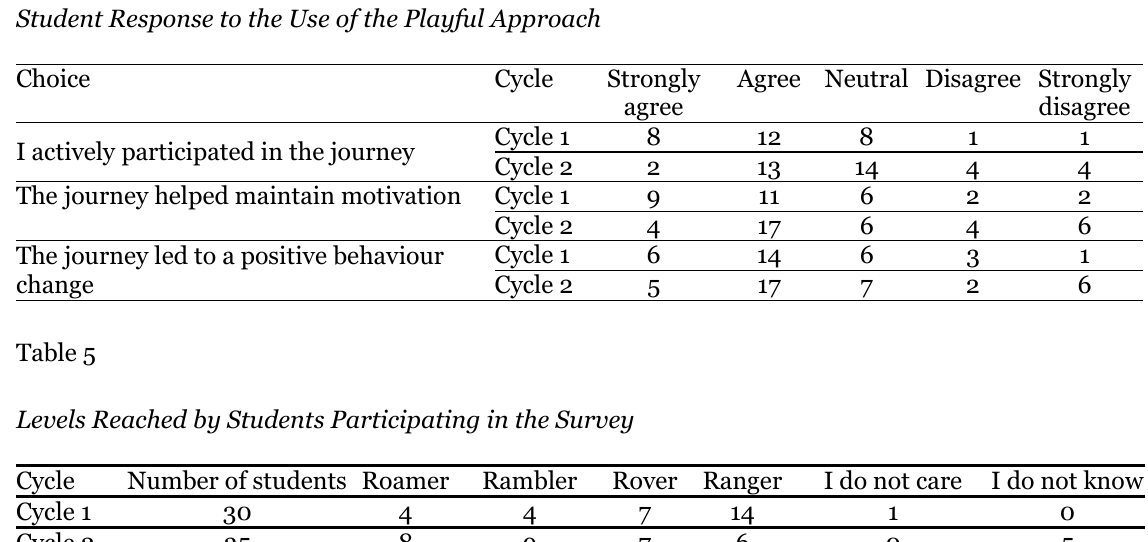
Levels Reached by Students Participating in the Survey Cycle Number of students Roamer Rambler Rover Ranger Cycle 1 Cycle